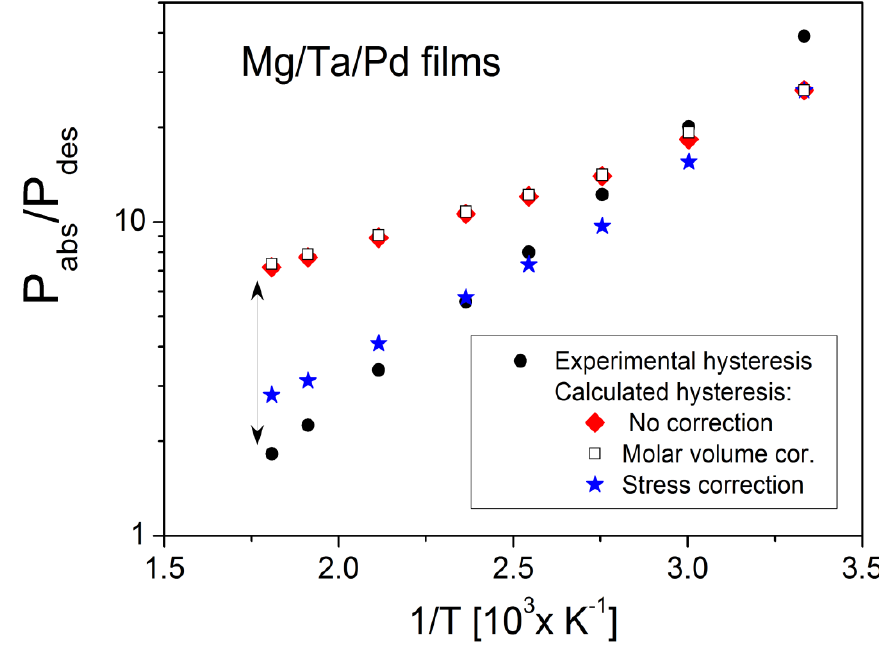
Figure 4. Comparison of the experimentally measured hysteresis (P films (black circles) and the calculated one with no temperature correction (red diamonds), with a molar volume temperature correction (open squares) and with a stress temperature correction (blue